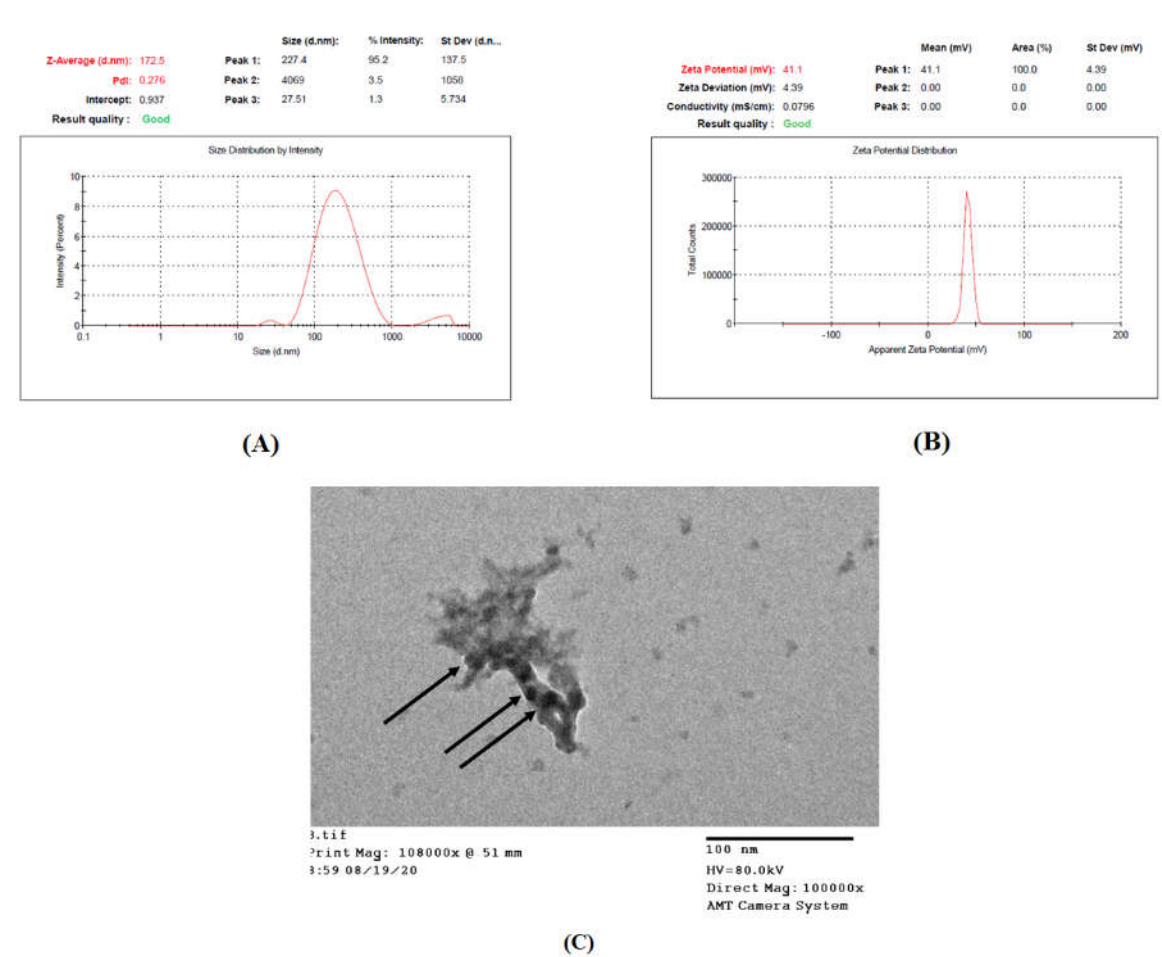
Figure 6. Optimized formulation characterization: ( A ) size distribution report, ( B ) zeta potential report, and ( C ) TEM image of the optimal formulation showing dense particle aggregation within a network.